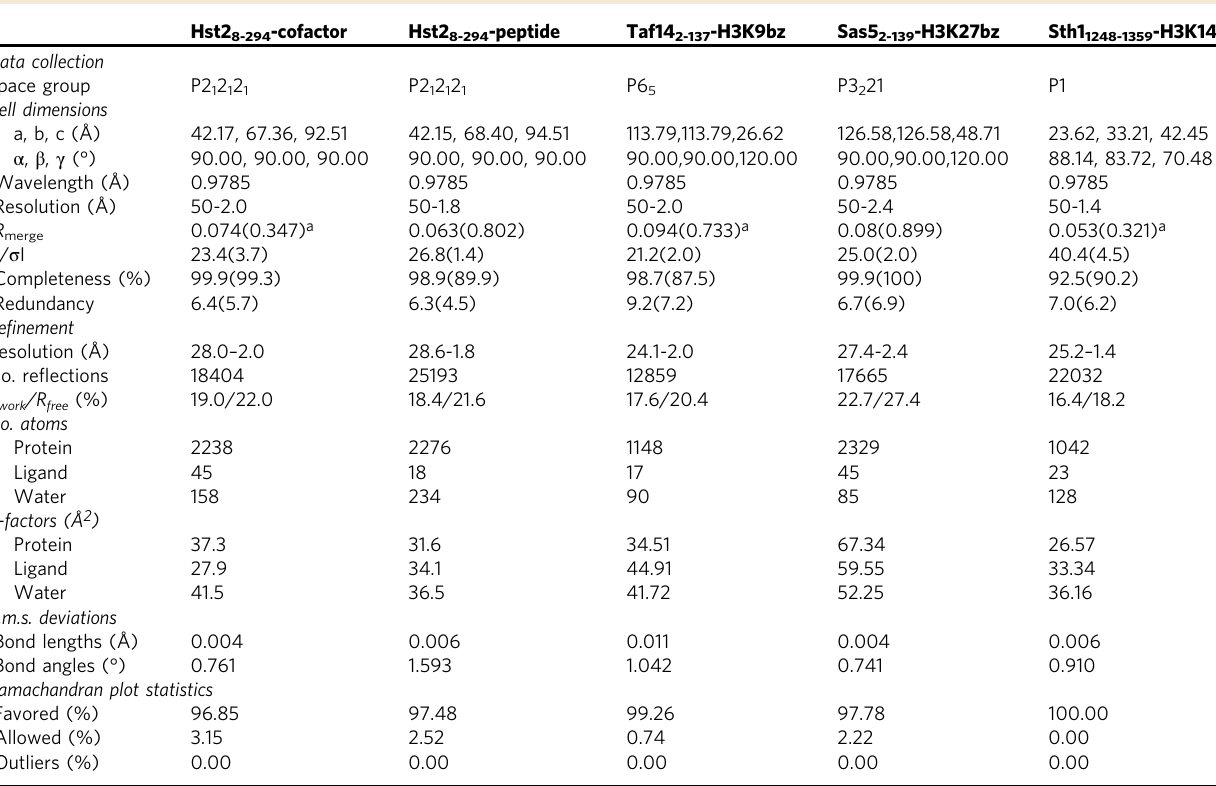
Table 1 Data collection and re fi nement statistics for crystal